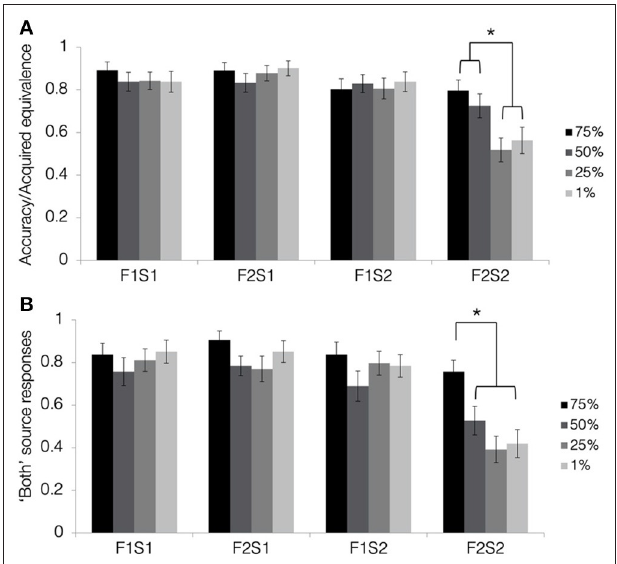
FIGURE 5 | Results from the tests of acquired equivalence and source memory in Experiment 2. (A) Acquired equivalence test accuracy for trained associations (F1S1, F2S1, and F1S2) and rates of acquired equivalence for untrained associations (F2S2). (B) For the source memory test, the proportion of trials where the participants responded that they had seen the items together during both study and test. This was the correct response for the trained associations but constituted a false memory for the untrained associations, since they were presented only during the test. All results are depicted separately for pair-mates at each blend level. Stars indicate a significant paired difference, following a significant test item type × shared parent blend level interaction effect (alpha =